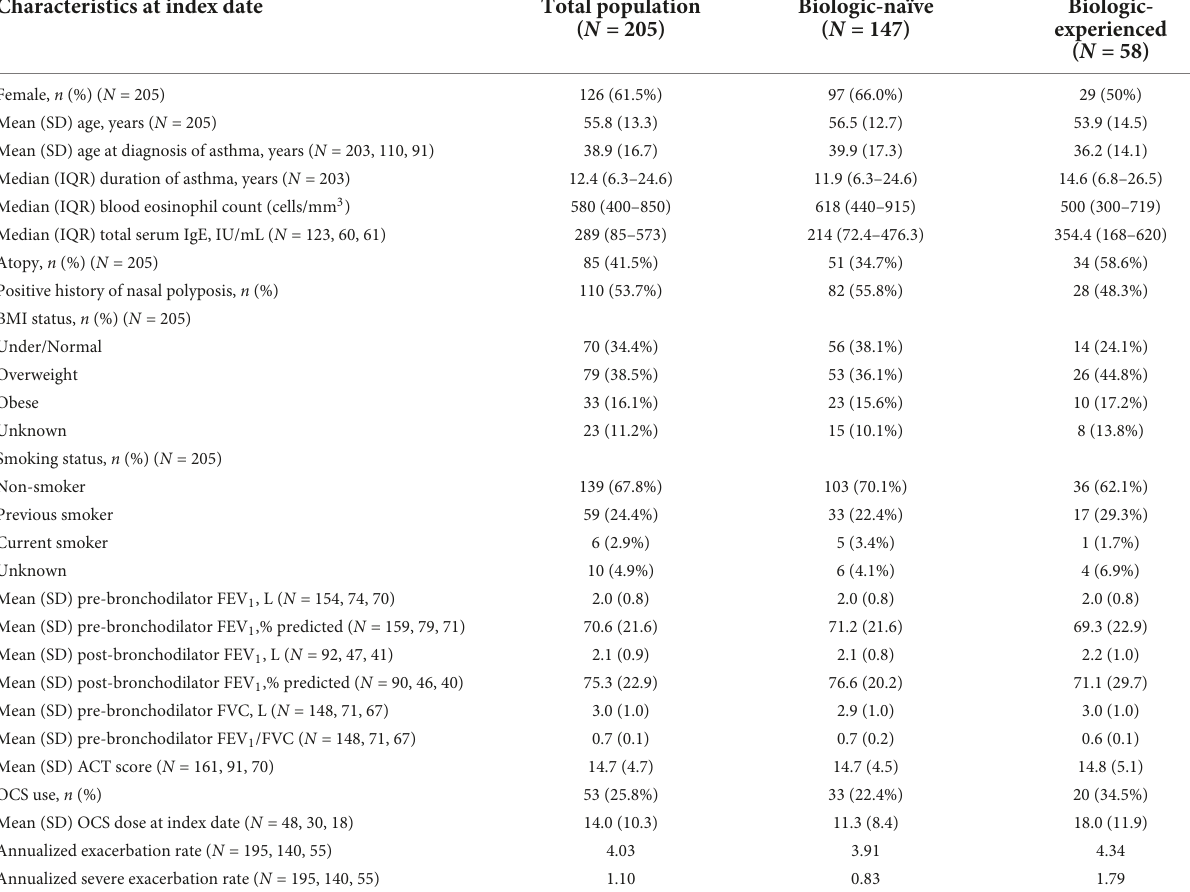
TABLE 1 Demographics, clinical, and laboratory features of the patient population.